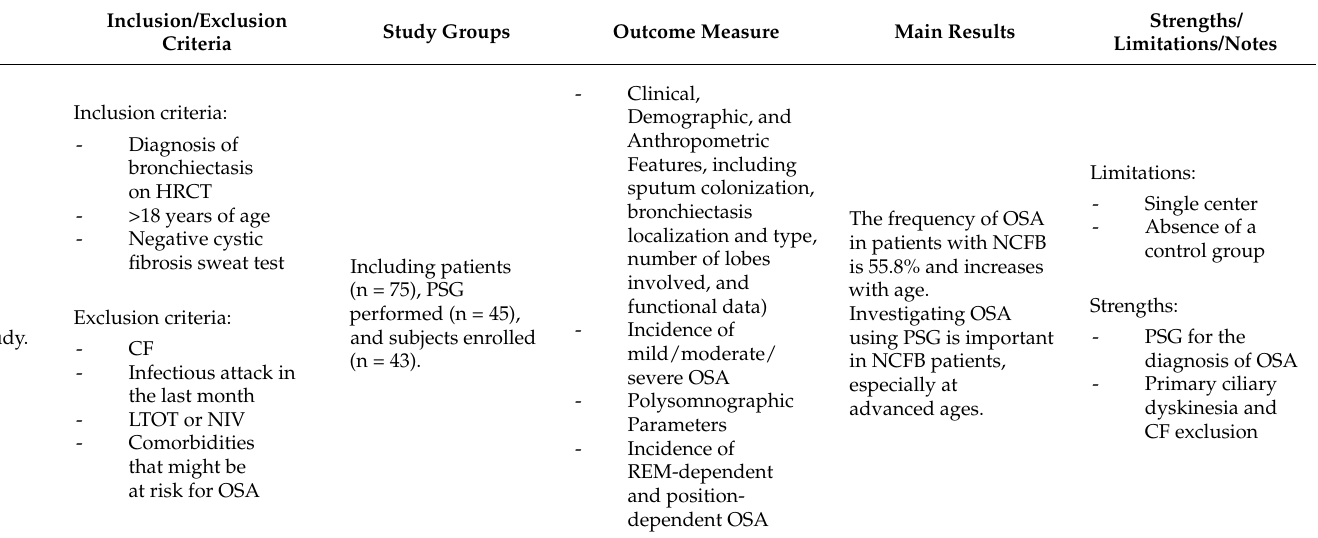
Table 2. Summary of the most relevant literature regarding the three main topics of this review (bronchiectasis, cystic fibrosis and mycobacterial